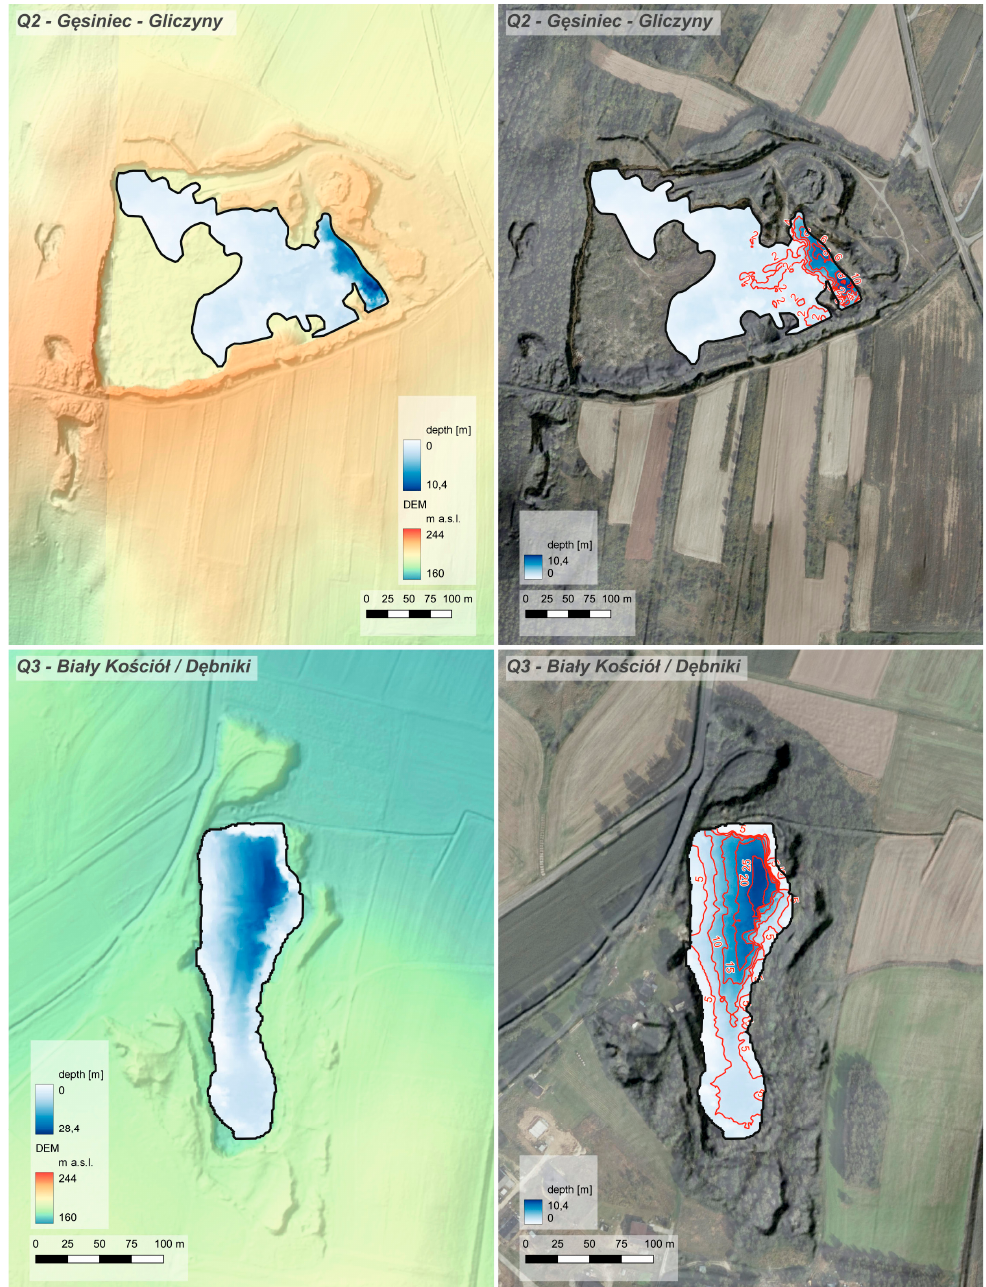
Figure 2. Sample bathymetric maps created for quarry lakes Q2 G ę siniec-Gliczyny and Q3 Bia ł y Ko ś ció ł D ę bniki (left side: DTM with a bathymetric map of the quarry lake, right side: orthophotomap with terrain formation and bathymetric map with isobates) (author T.K.).